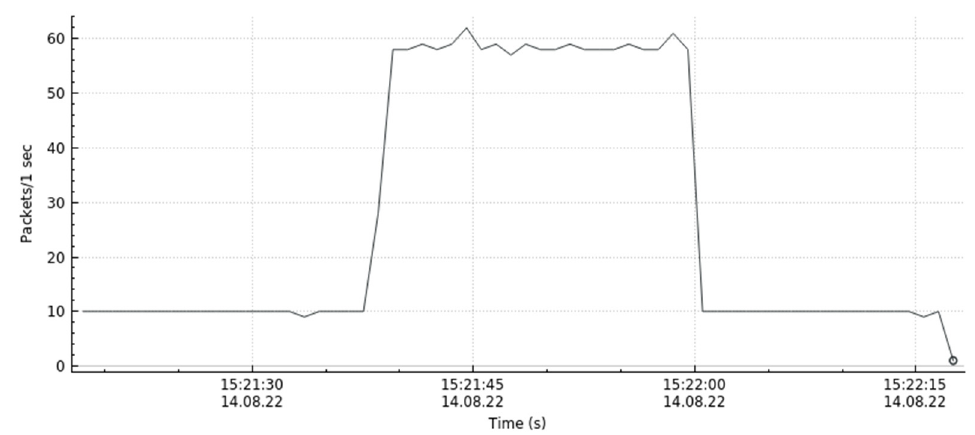
Figure 11. h3 Flow trend after defensive measures.